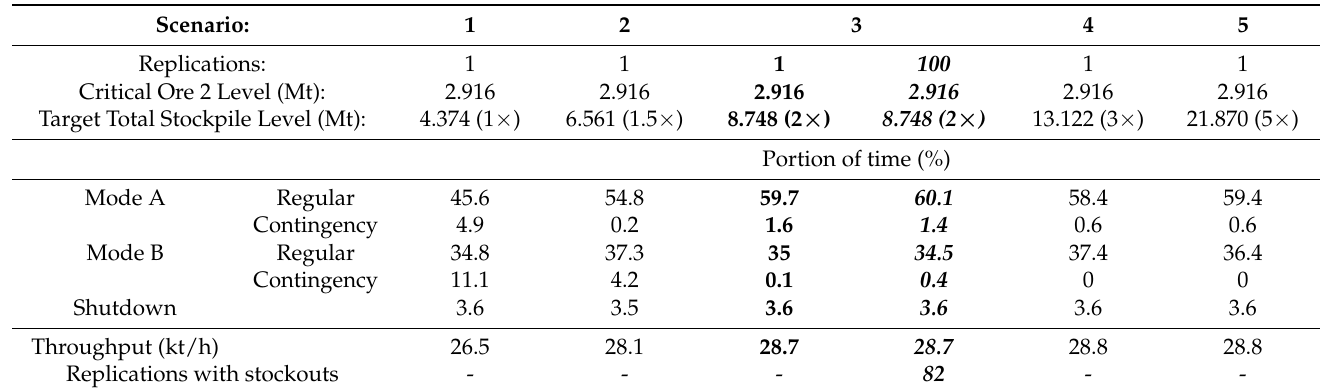
Table 7. Distribution of time spent in each mode type under varied target total stockpile levels.